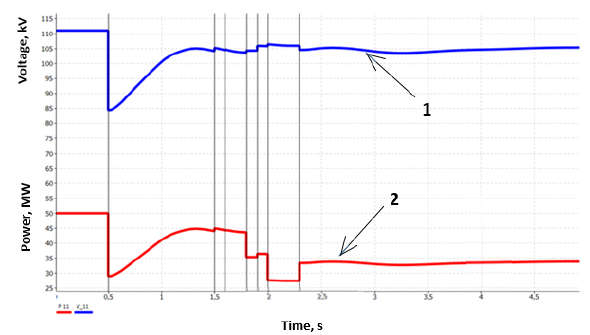
Fig. 3. Dynamics of changes in voltage (1) and power (2) consumption of the load at node